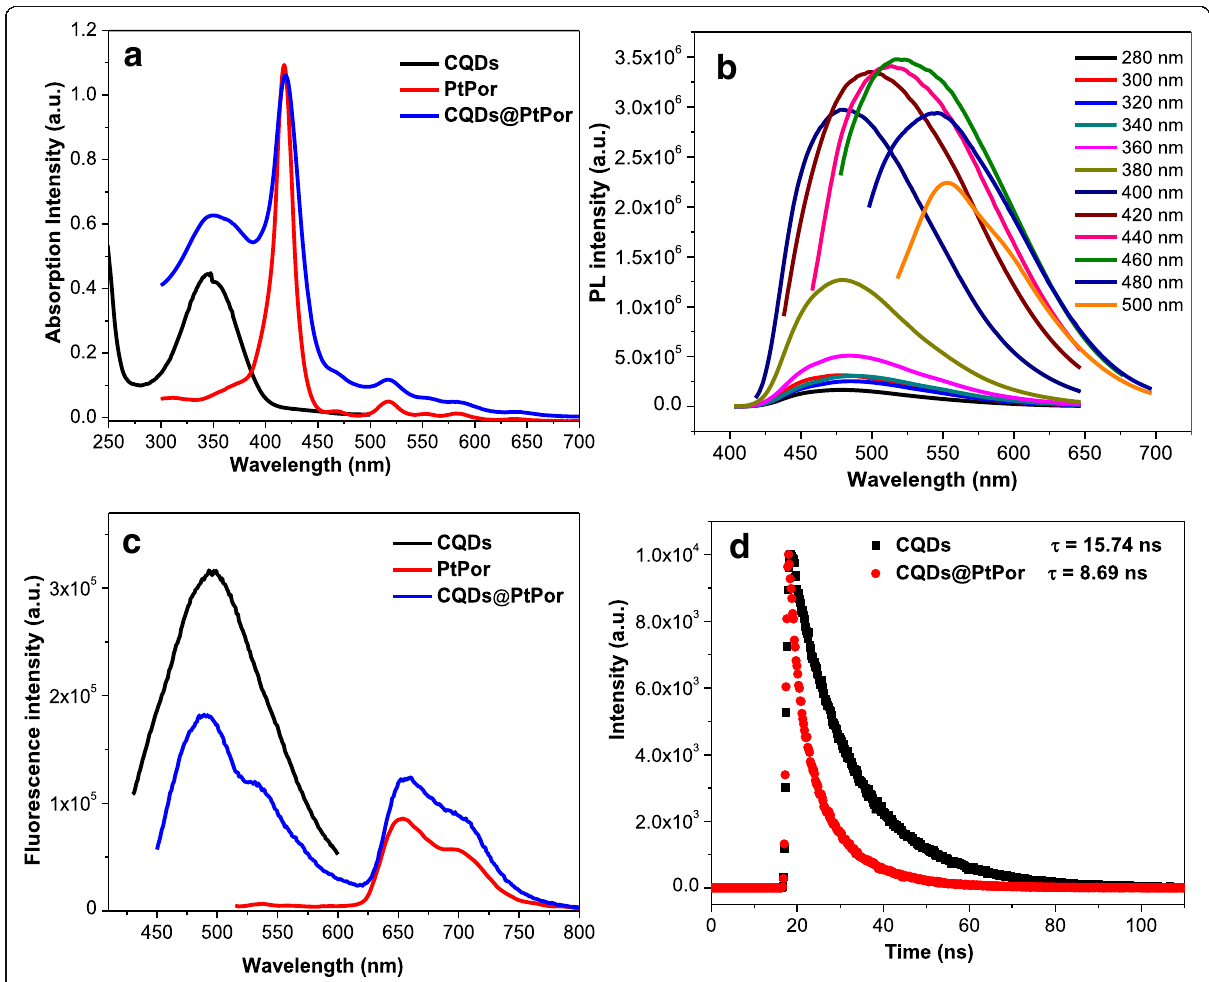
Fig. 4 UV-Vis absorption ( a ) and fluorescence ( b ) spectra of CQDs, PtPor, and CQDs@PtPor. Fluorescence spectra ( c ) of CQDs with different excitation wavelengths. Fluorescence decays ( d ) of CQDs and CQDs@PtPor. The concentration of samples: CQDs (5 μ g/mL), CQDs@PtPor (5 μ